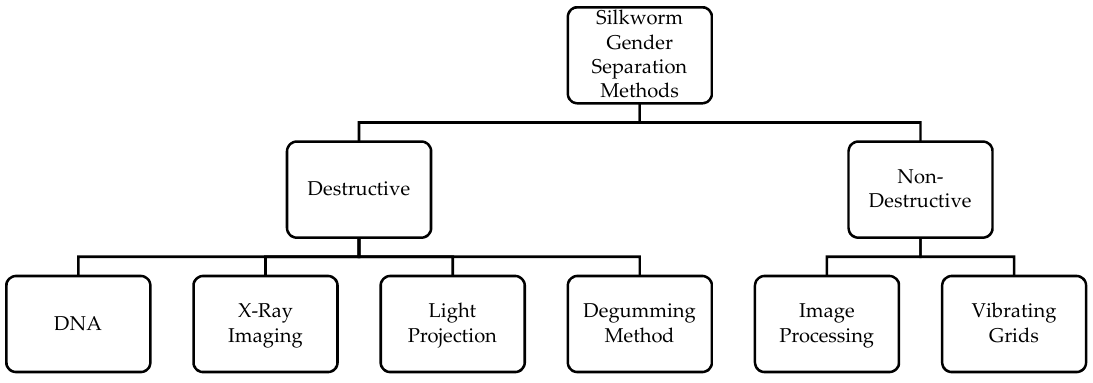
Figure 3. Methods of silkworm gender separation process.